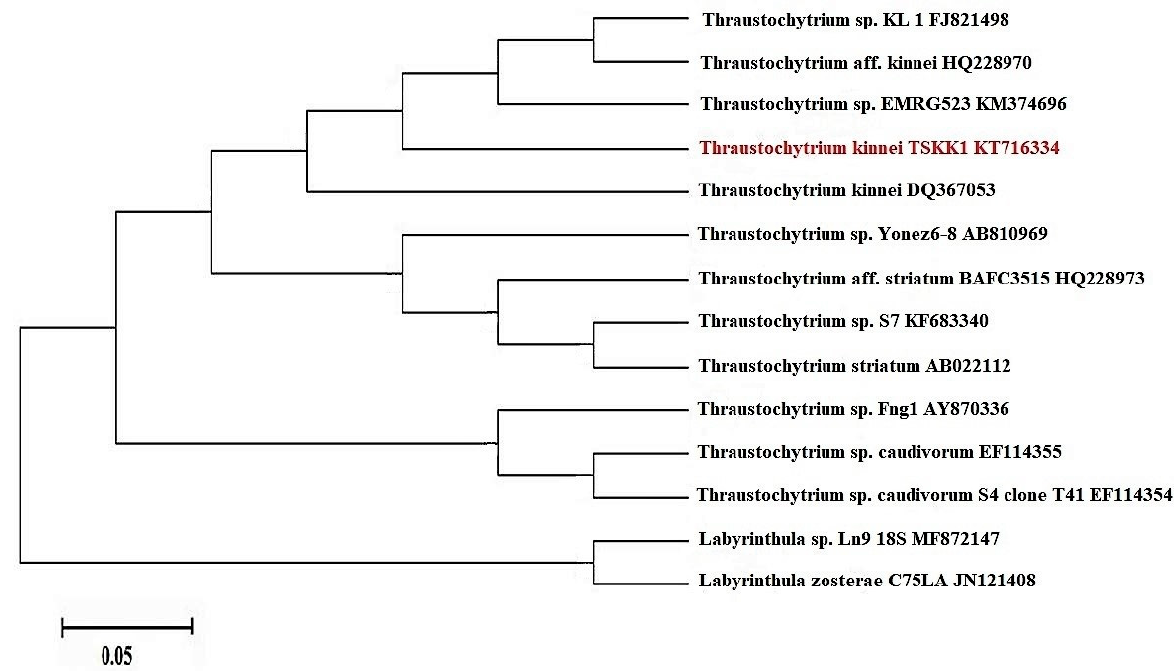
Figure 2. Neighbor joining phylogenetic tree of thraustochytrid strain TSKK1 ( Thraustochytrium kinnei ) using 18S rRNA gene sequence data.